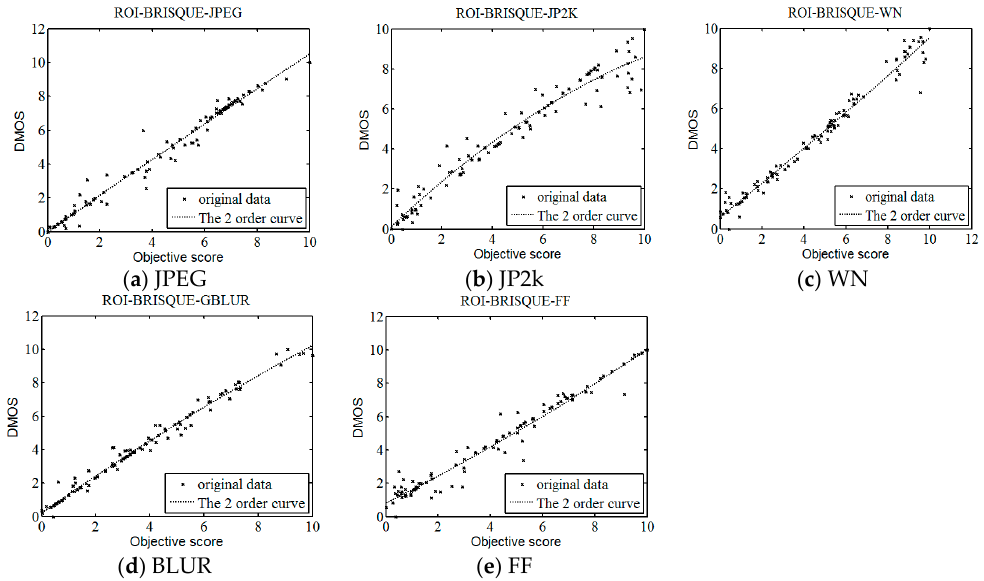
Figure 14. Scatter plots of JPEG, JP2k, WN, BLUR and FF. Scatter plots of predicted score versus subjective DMOS on LIVE IQA database. ( a ) JPEG database subset; ( b ) JPEG2000 database subset; ( c ) Gaussian white noise database subset; ( d ) Gaussian blur database subset; ( e ) fast-fading database subset.